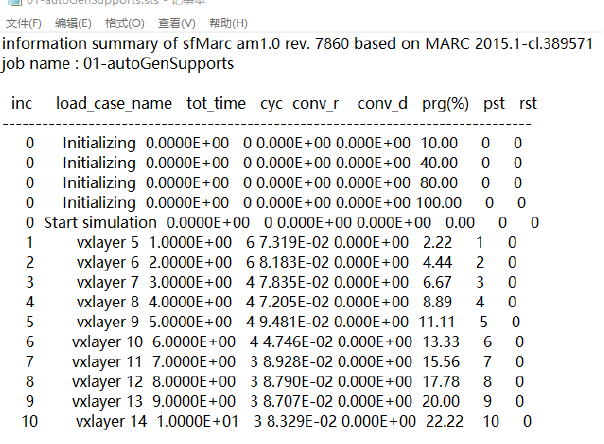
Fig. 8 Raw data in the status file.